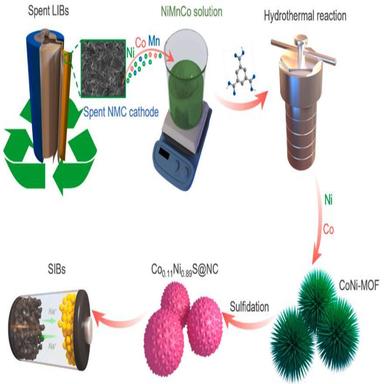
Illustration of the synthetic procedure of Co0.11Ni0.89S@NC from spent LIBs.